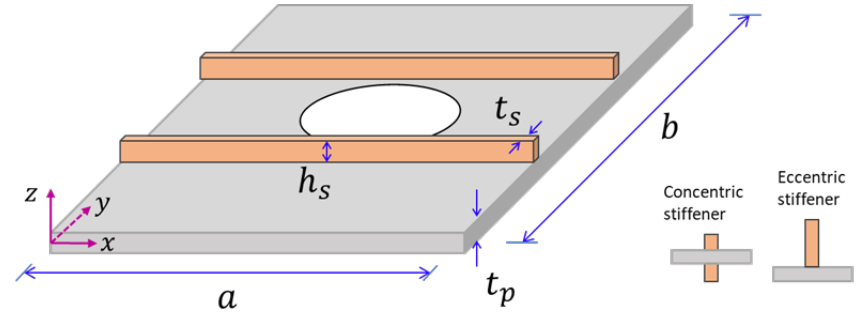
Figure 5. Stiffened plate with a central